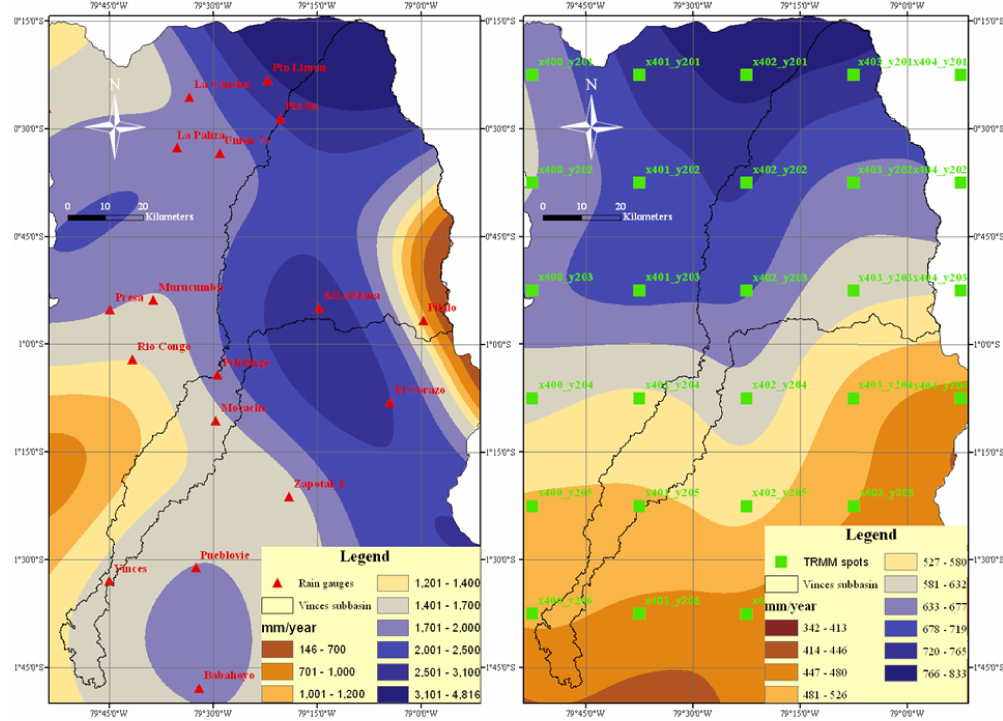
Fig. 2. Annual average rain field comparison between ground stations (left) and TMPA-3B42R research data (right), during